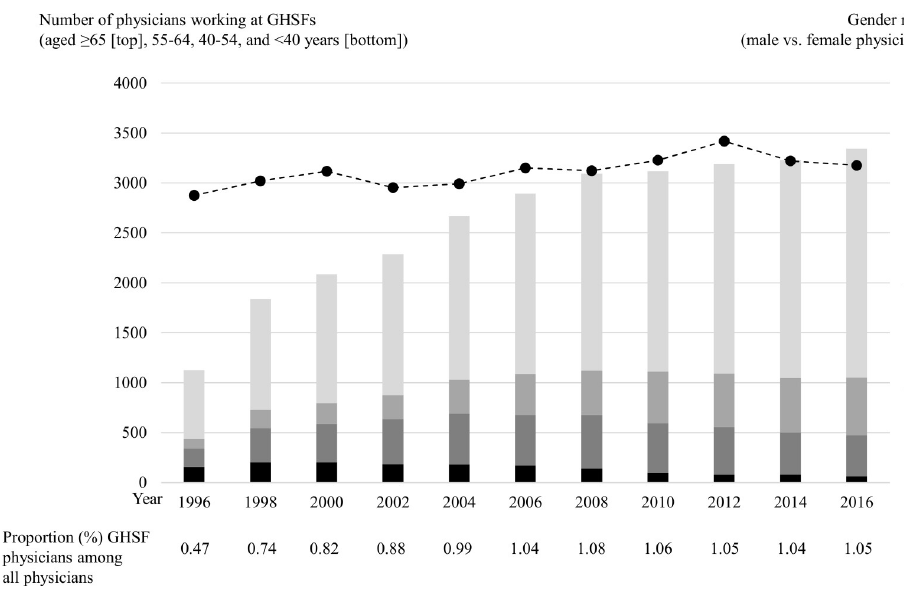
Fig 1. Temporal trend in the number (overall and by age category), proportion, and sex ratio of physicians working at GHSFs in Japan from 1996 to 2016. GHSFs = geriatric health service facilities.